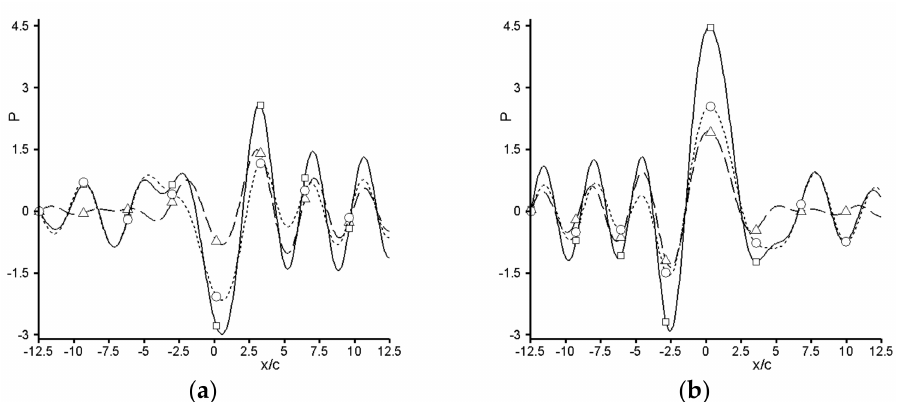
Figure 3. Low frequency ( St = 0.294) noise radiation from the trailing edge of an airfoil set at relatively high incidence ( α = 20 ◦ ). Instantaneous pressure fields, as recorded along the top ( a ) and bottom ( b ) walls. Incident field ( p inc ( x , t ) ), long dashes with delta symbols), all reflected fields ( p small dashes with circle symbols), total field ( p ( x , t ) , solid line with square symbols). For visualization purposes, the pressure fields are here normalized by A max